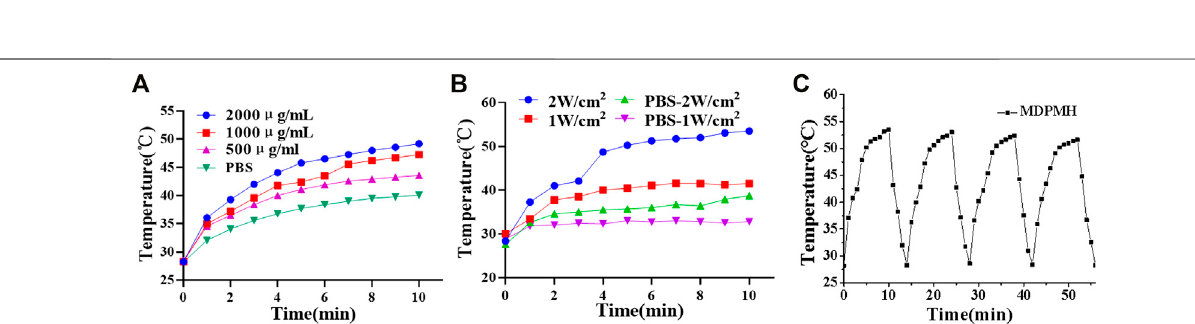
FIGURE 4 | Mass of cumulative Mn 2+ (A) and mass percentage of DTX (B) released from MDPMH in buffer solutions (pH = 7.4, pH = 5.5 + HAase and pH = 7.4 + HAase) at 37 ° C.